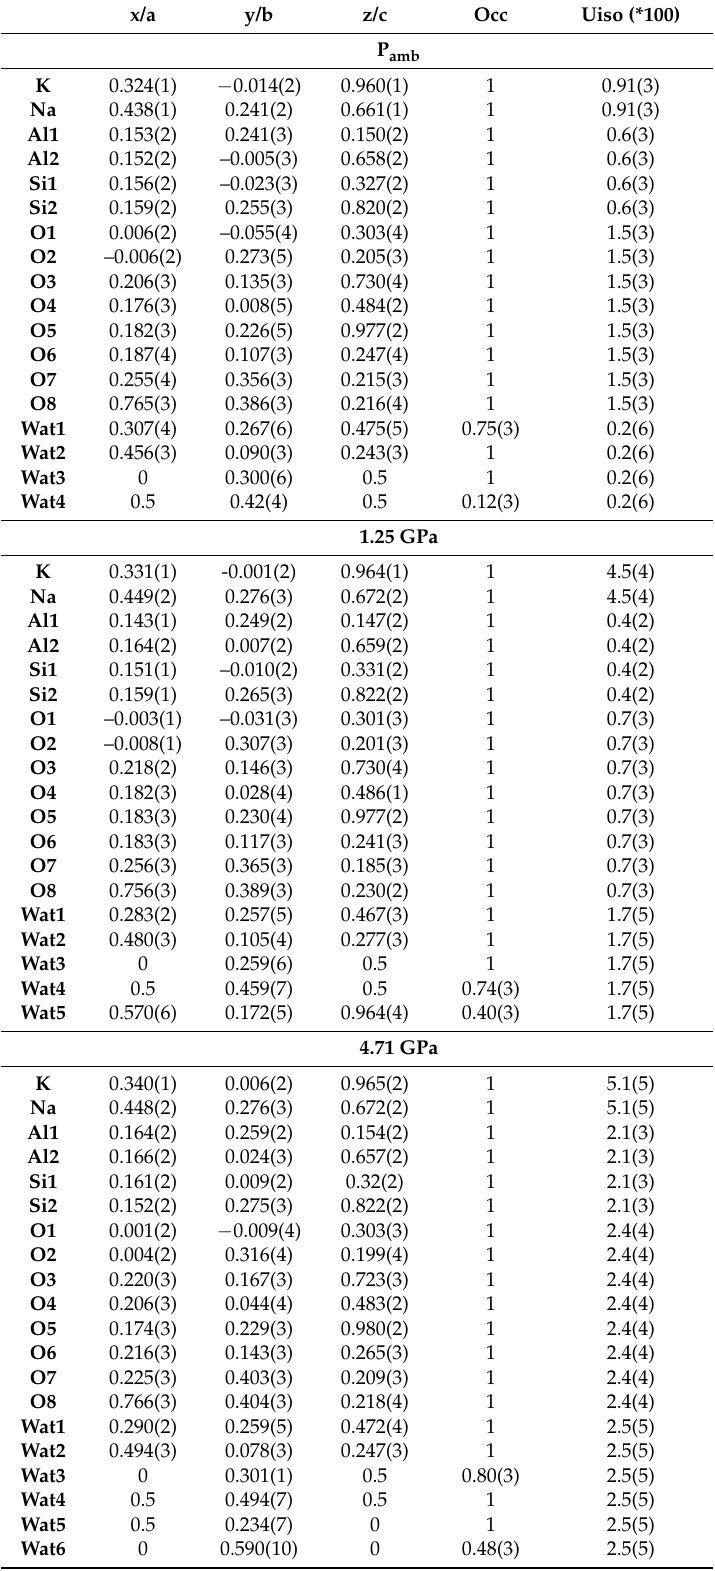
Table 3. Refined atomic positions, occupancy factors, and displacement parameters of amicite at P amb